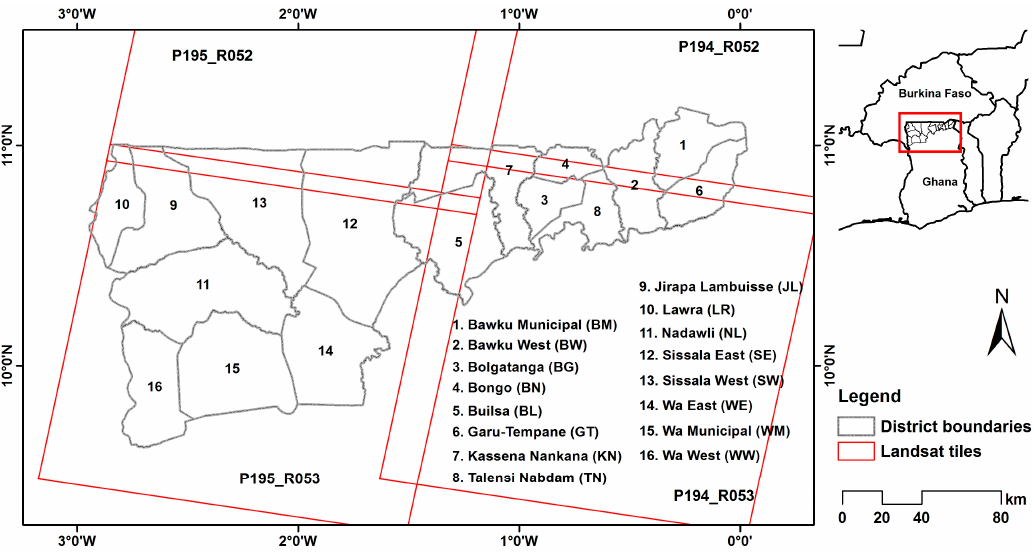
Figure 5. Map of the administrative units for which government’s agricultural statistics were compared with remote sensing estimates, overlaid with the boundaries of Landsat tiles.